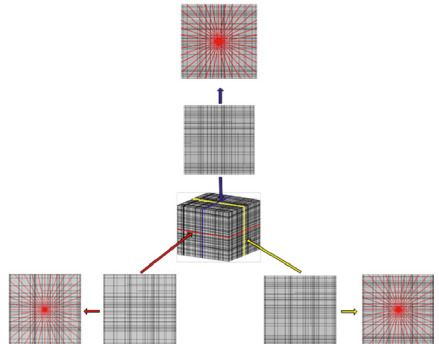
Figure 4: Illustration of setting scanlines in a model. Table 5: Standard ratings of MB